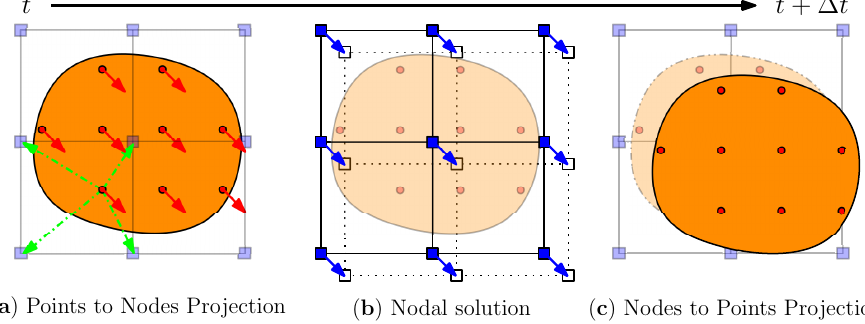
Figure 6. Typical calculation cycle of an MPM solver. ( a ) The continuum (orange) is discretised by Lagrangian material points (red dots), for which state variables (e.g., mass or stress tensor) are